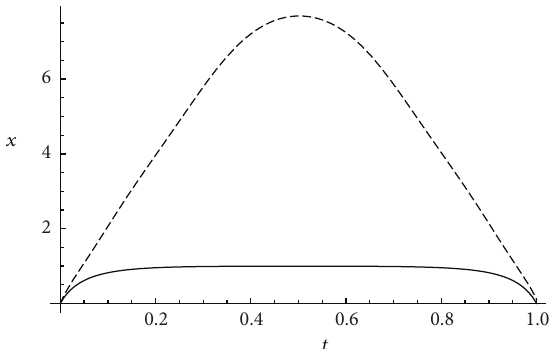
Figure 8: Two solutions of problem (15), (10), 𝛼 ≈ 22.9775 , 𝛼 ≈ 29.8788 .